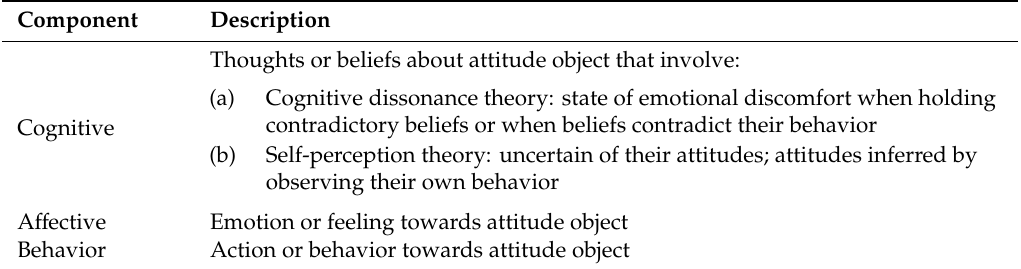
Table 1. Tri-partite theory of